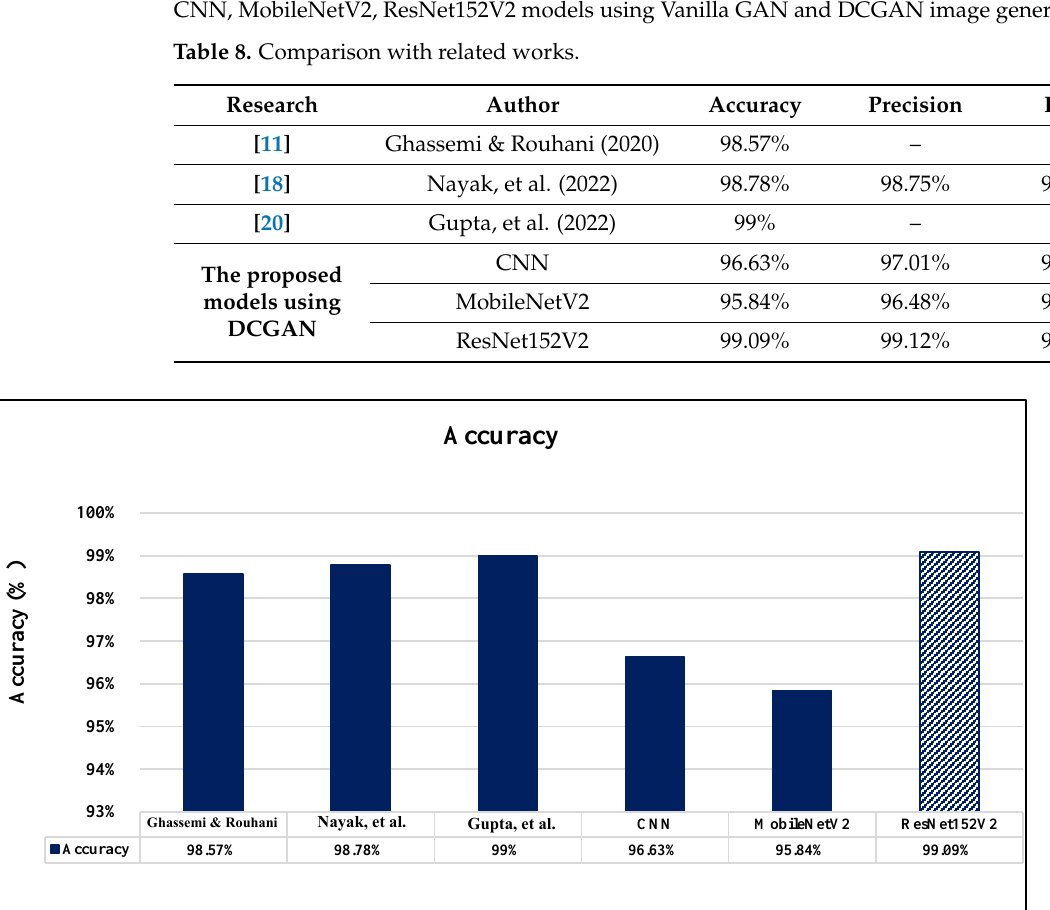
Figure 17. Precision performance metrics comparison between our proposed models and previous studies [18] .